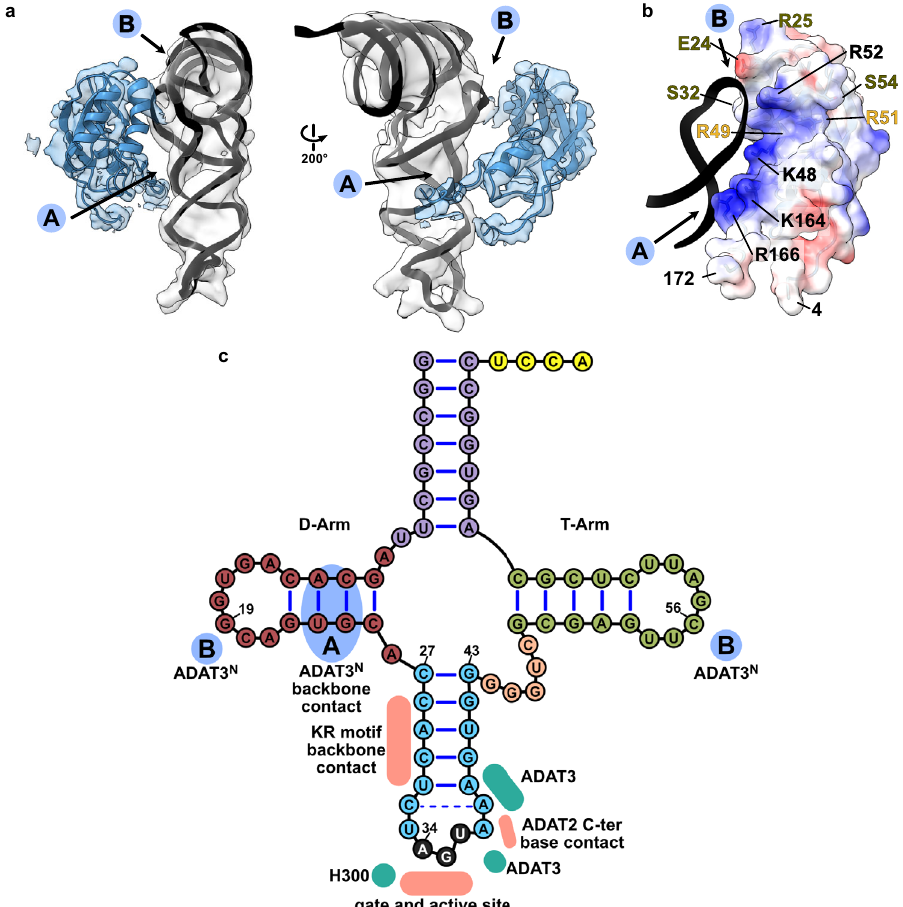
Fig. 5 | ADAT3 N-terminal domain probes the three-dimensional structure of thetRNA.a TwoviewsoftheADAT3 N fi ttedinthepost-processedEMmap,inblue, with ‘ A ’ and ‘ B ’ regions as the two contact points of our model with tRNA, as indicatedinC. b ADAT3 N includinglinkers(residues4 – 172);surfacemodelcolored by vacuum electrostatic potential, positive charges in red and negative charges in